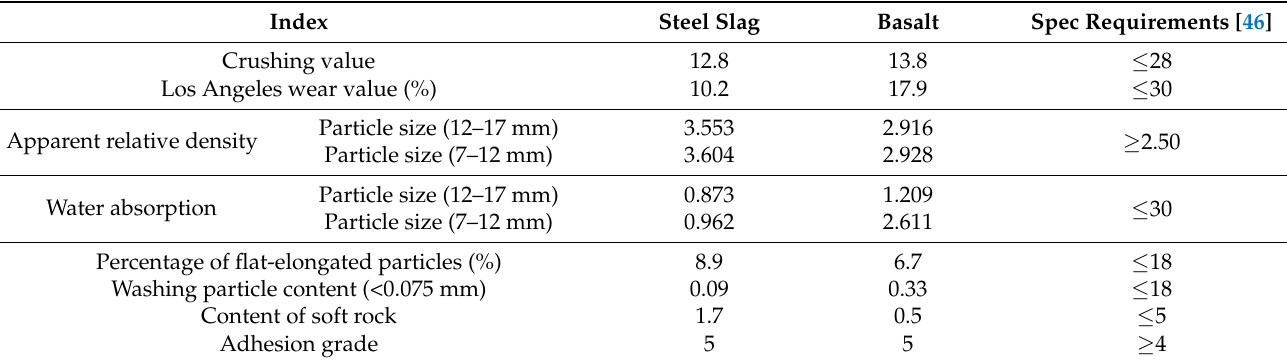
Table 1. Technical indices of the basalt and steel